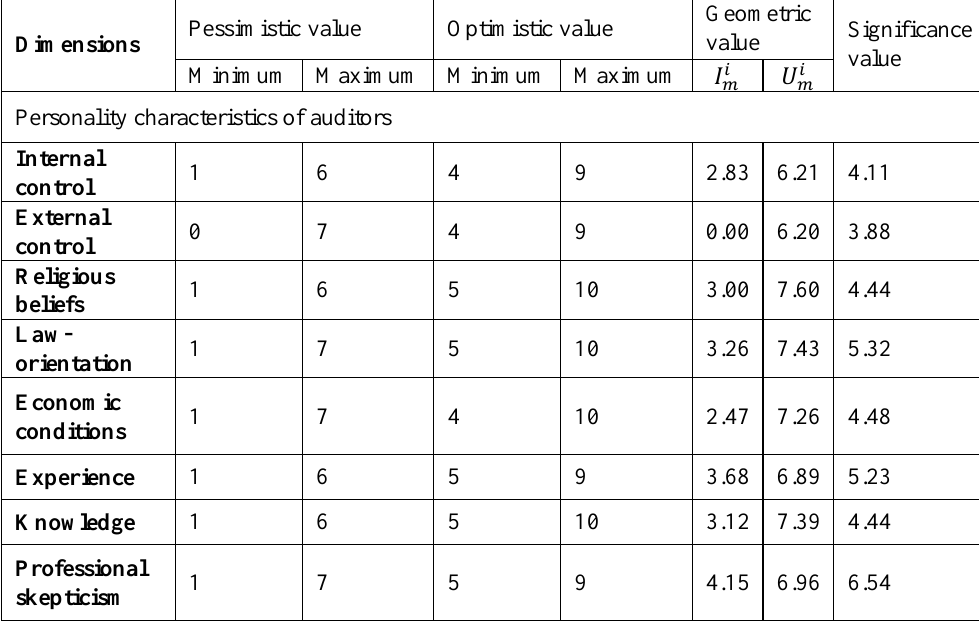
Table 2. Performance indicators based on the Fuzzy Delphi method Pessimistic value Optimistic